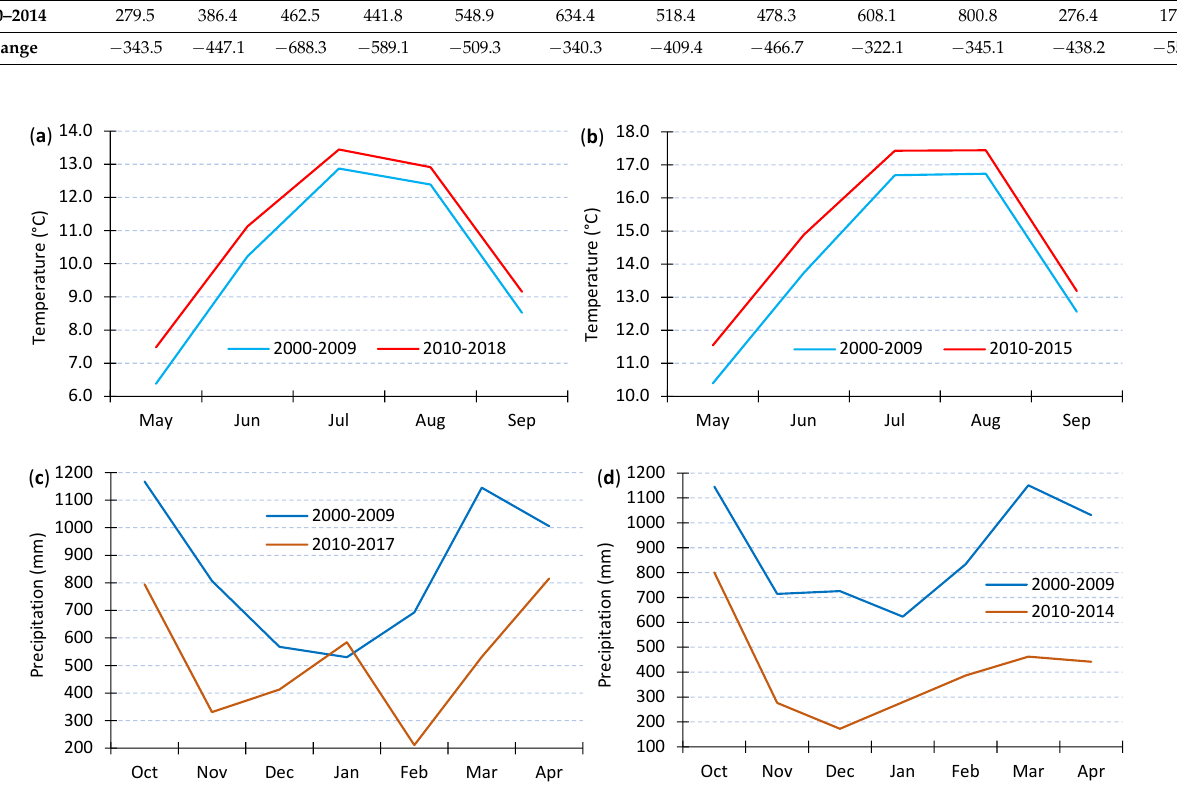
Figure 11. Average May–September monthly air temperatures for the Terskol meteorological station in 2000-2009 and 2010-2018 ( a ) and for the Mestia meteorological station in 2000-2009 and 2010-2015 ( b ); Sum of the October–April precipitation for the Terskol meteorological station in 2000-2009 and 2010-2017 ( c ) and for the Mestia meteorological station in 2000-2009 and 2010-2014 ( d ).